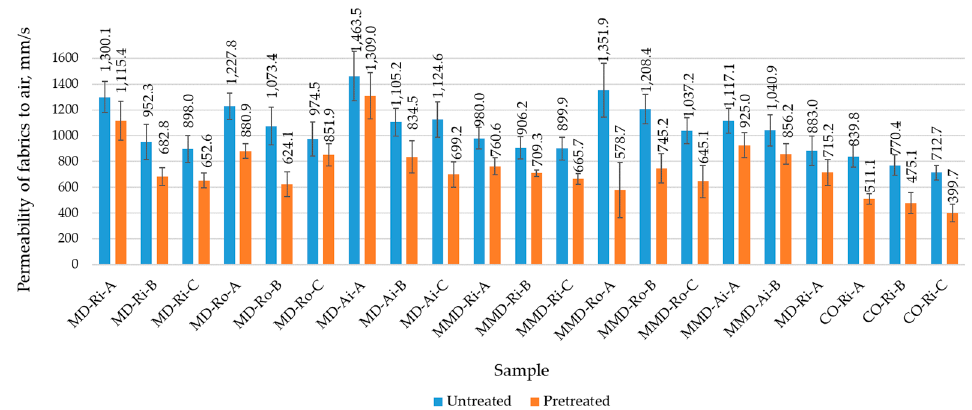
Figure 15. Air permeability of the untreated and pretreated sock plain knit samples determined before and after five repeated washing and drying cycles of the socks (where MD—modal fibers, MMD—micro modal fibers, CO—cotton fibers; Ri—ring spun yarn, Ro—rotor spun yarn, Ai—air-jet spun yarn; A, B, C—sock group).